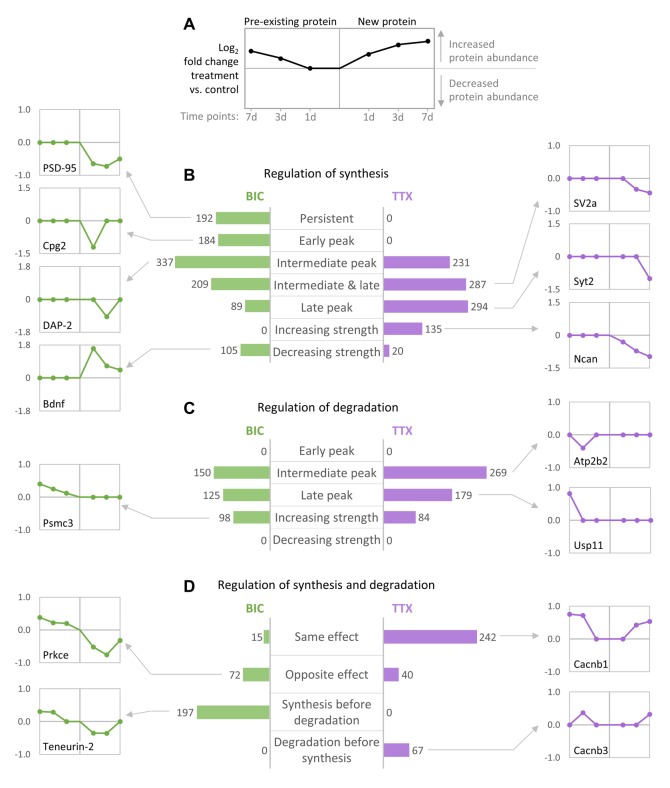
Temporal profiles of protein synthesis and degradation during homeostatic scaling.Predominant temporal profiles of pre-existing and newly synthesized proteins observed during BIC-induced down-scaling and TTX-induced up-scaling. Proteins were clustered using their temporal profiles of pre-existing and newly synthesized proteins (k-means clustering), and the resulting clusters of proteins with similar profiles were manually assigned to upper-level groups (see Figure 8—figure supplements 1,2). (A) Description of graphs in panels (B–D) showing exemplary profiles. (B–D) The bar diagrams show the numbers of individual proteins assigned to upper-level groups that are mainly characterized by changes in synthesis (B), degradation (C) or both (D). Representative temporal profiles of proteins regulated during BIC-induced down-scaling (green) or TTX-induced up-scaling (purple) are shown.Figure 8—source data 1.Temporal protein regulation during homeostatic up- and down-scaling.